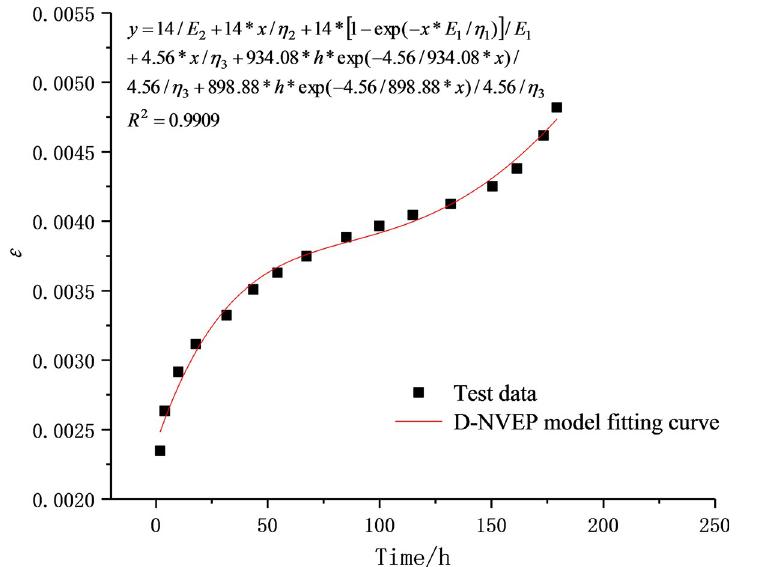
Fig 11. Fitting curve of D-NVEP